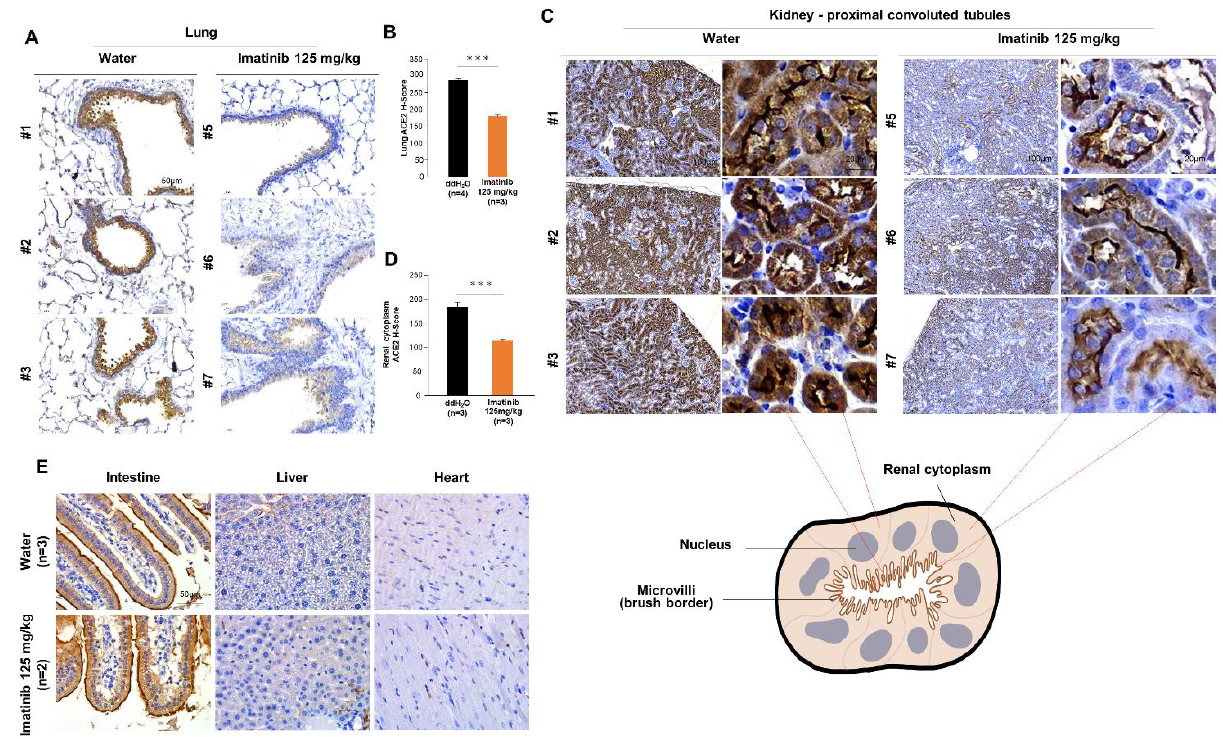
Figure 5. Imatinib treatment reduced the expression of ACE2 in a tissue-specific manner. FVB mice were fed with imatinib or water for one week, and the organs were isolated and processed for analysis by IHC of ACE2. ACE2 staining was assessed by Allred scoring for the lungs ( A , B ), the kidneys ( C , D ), and other organs, including the intestine, liver, and heart ( E ). In ( C ), the boxed areas are magnified to show the detailed structures of the proximal convoluted tubules. Bars, standard deviation; *** p < 0.001 determined by Student’s t -test.